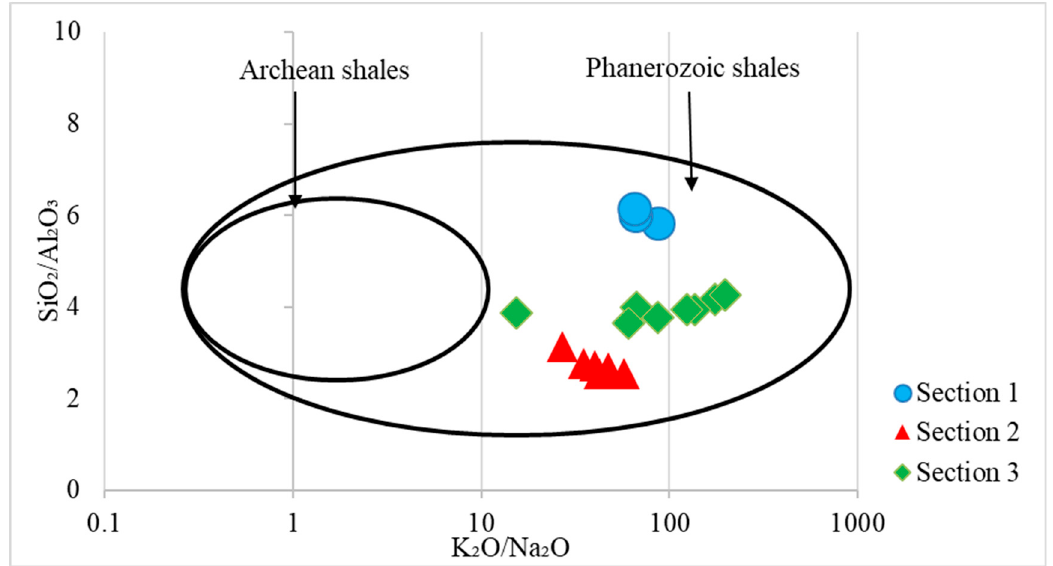
Figure 8. The plot of SiO 2 /Al 2 O 3 versus K 2 O/Na 2 O for shales of the Chichali Formation.